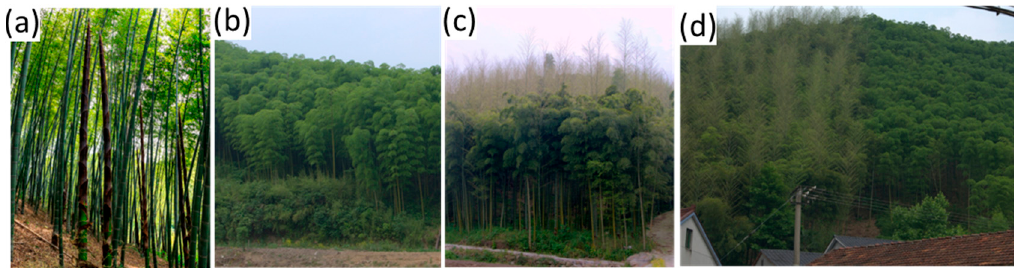
Figure 1. Photos showing on-year and off-year bamboo forests. ( a ) New bamboo shoots; ( b ) off-year bamboo forests; ( c ) new bamboo trees in the on-year bamboo forests; ( d ) clear boundary between on-year and off-year bamboo forests.